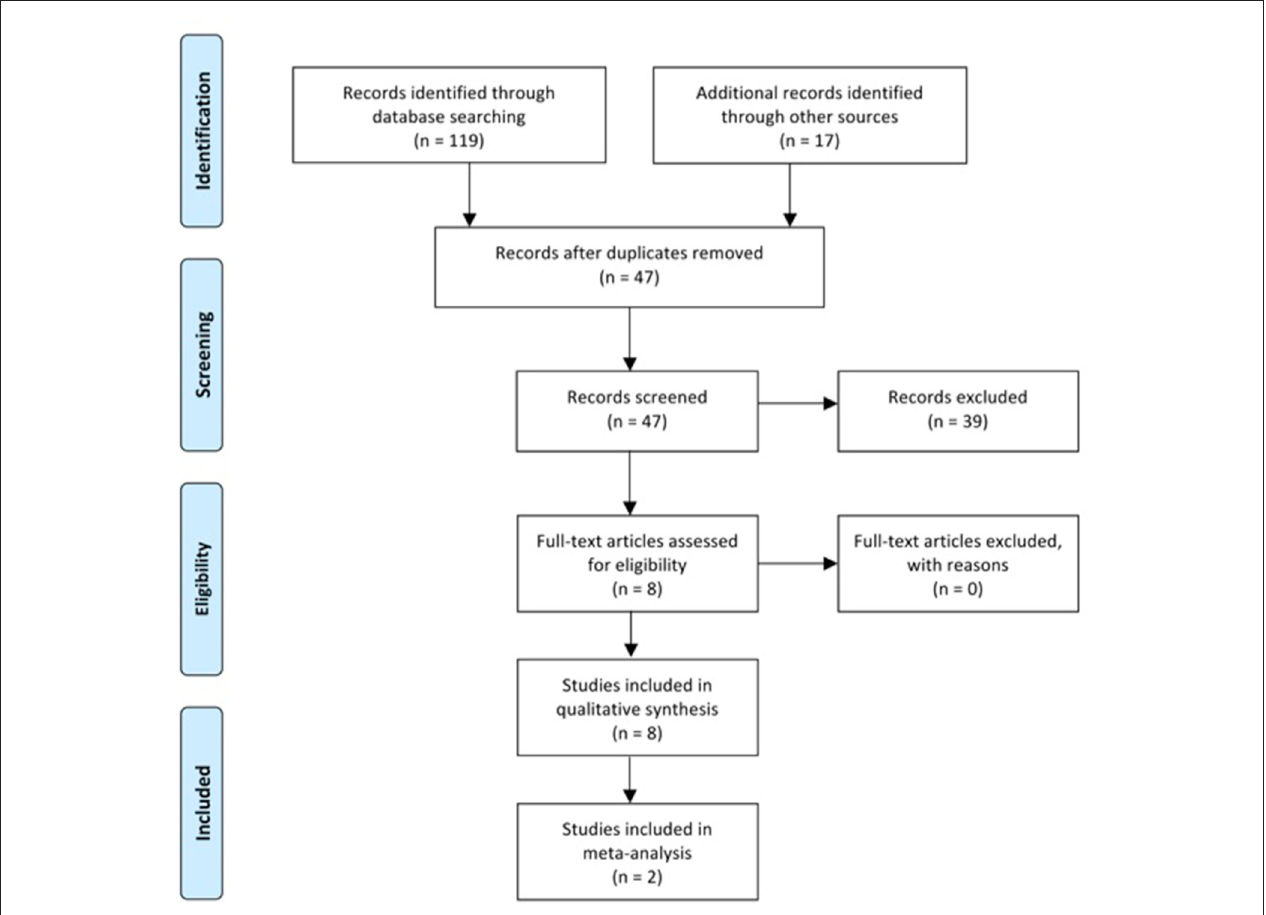
FIGURE 1 | Flow diagram of PRISMA depicting each step of study